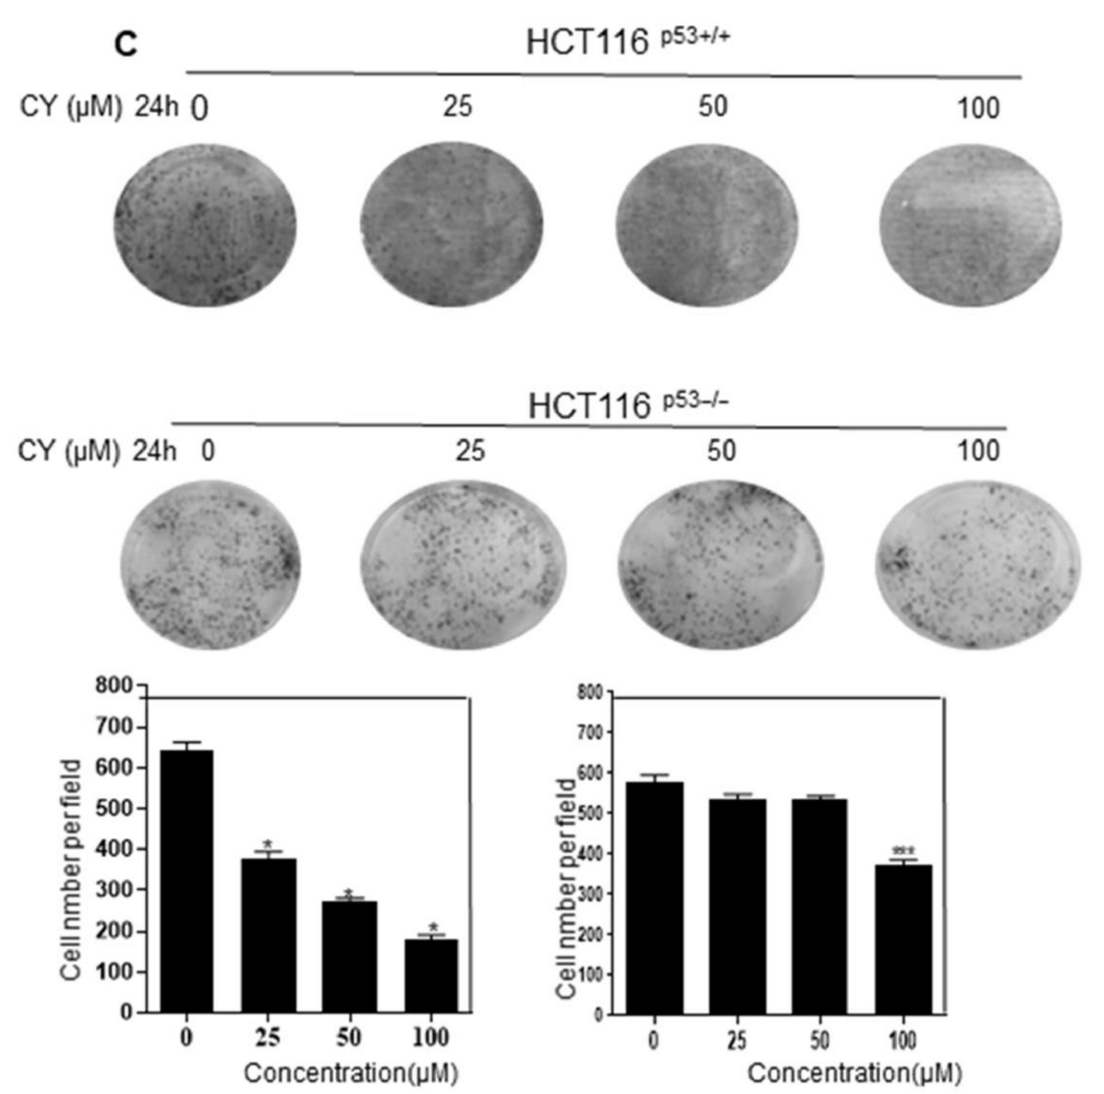
Figure 1. Effects of cycloastragenol (CY) on HCT116 p53+/+ , HCT116 p53 − / − and HT29